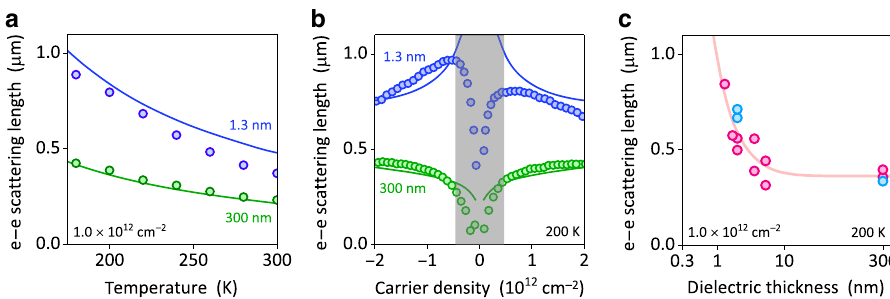
ð T Þ extracted from Hall viscosity measurements for the given n . Data for a Fig. 2 Dependence of the e-e scattering length on distance to the gate. a ‘ ee close-gate device (blue symbols) are compared with a reference (green). b Density dependence of ‘ at 200 K (same color coding as in a ). The gray- ee shaded region indicates the regime near the NP where the single-component hydrodynamic theory is not applicable 12,13,20 and, also, the cyclotron diameter became comparable with the width of our devices 15 . c ‘ as a function of d for the given n and T . Red and blue symbols: Results from Hall viscosity and ee point-contact measurements, respectively; shown are the average values for electron and hole doping (see panel b for an example of scatter due to electron – hole asymmetry). For all the panels, the solid curves are theoretical results (Supplementary Note